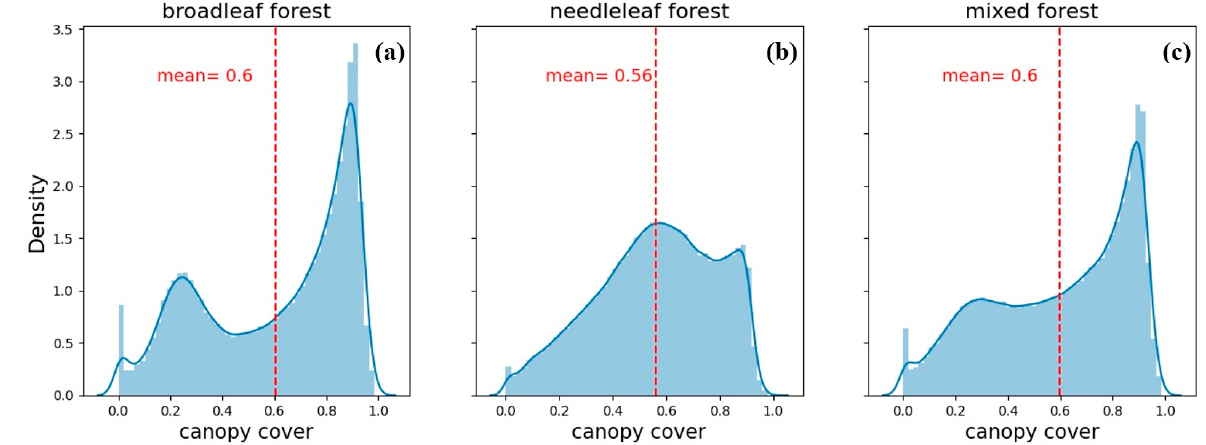
Figure 6. Distribution of canopy cover over ( a ) broadleaf ( b ) needleleaf, and ( c ) mixed forest.